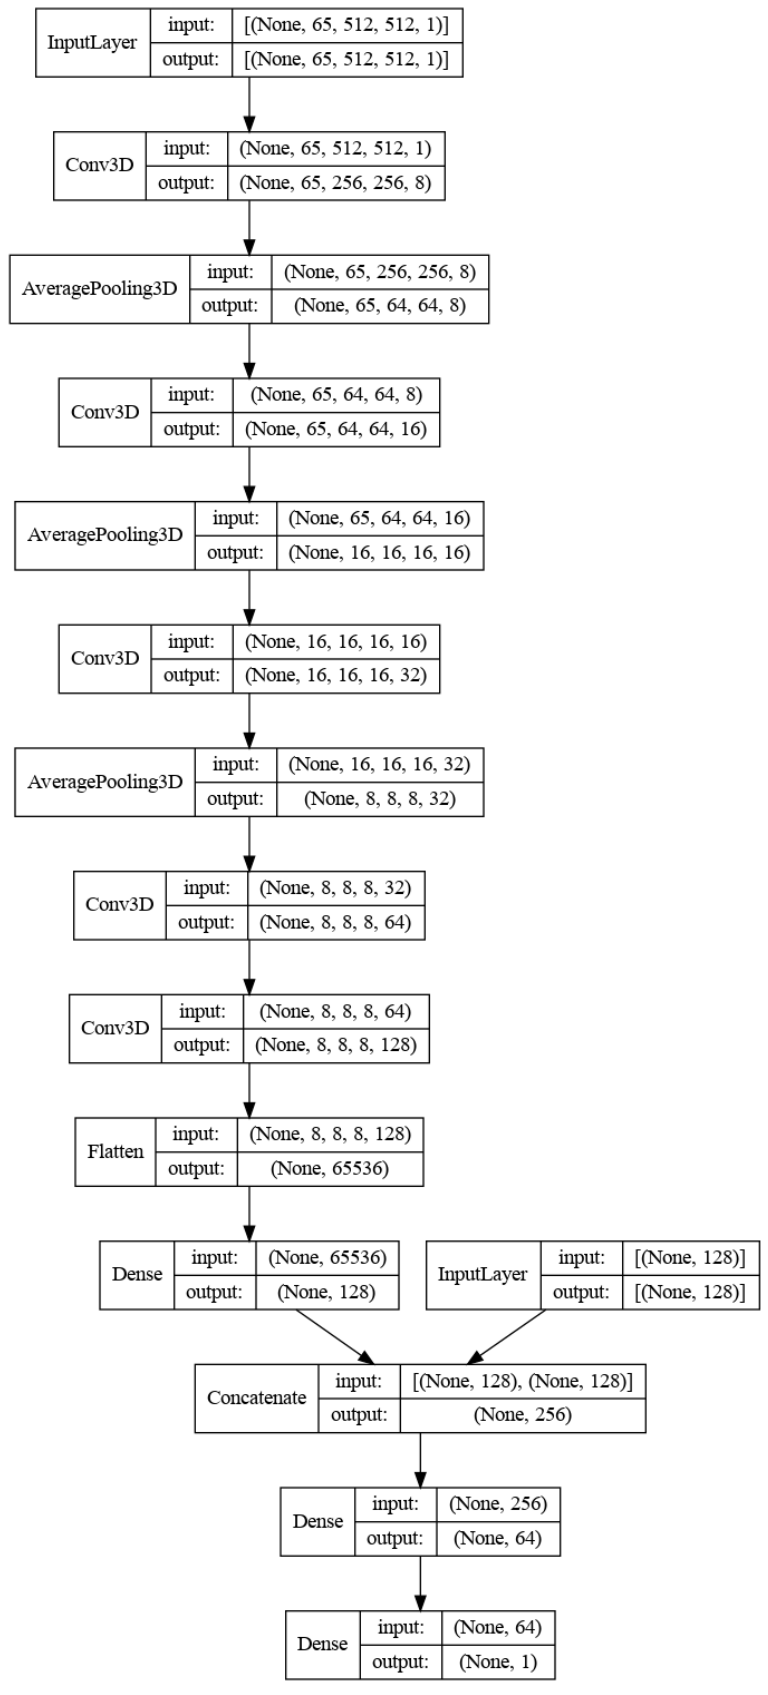
Figure 2. Architecture of the CNN representing the proposed ML